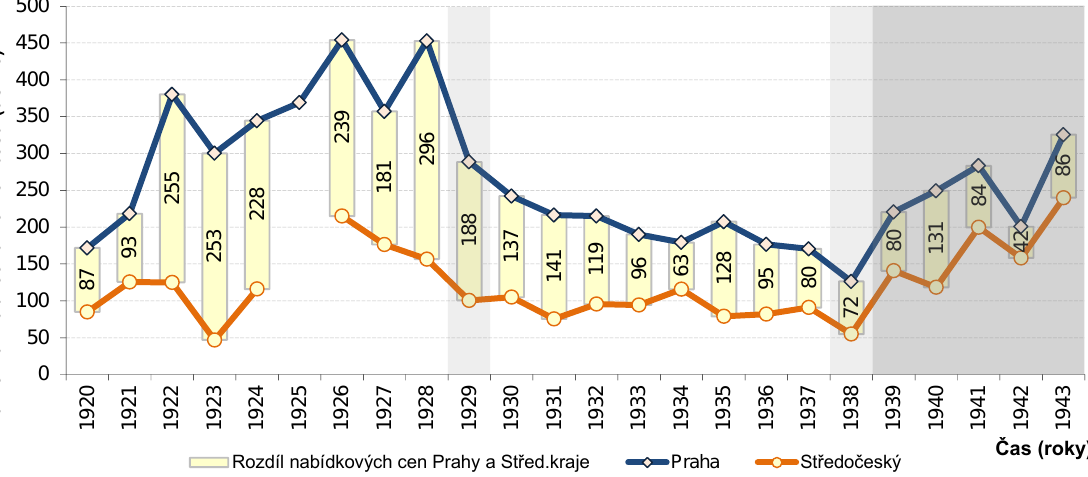
Obrázek 7: Vývoj průměrné nákladové ceny rodinného domu v Praze a ve Středočeském kraji včetně rozdílu